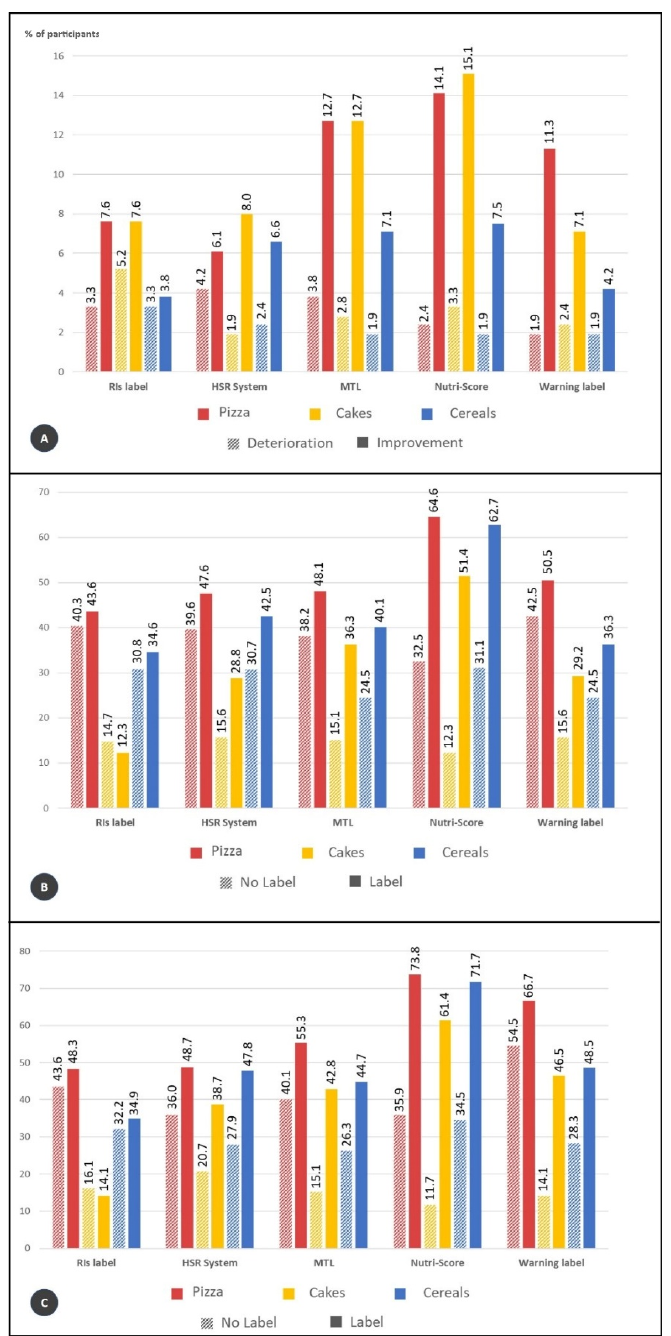
Figure 2. ( A ) Percentages of participants whose food choices deteriorated and improved; ( B ) Per- centages of participants providing correct answers for ranking tasks; ( C ) Percentages of participants providing correct answers for ranking task only among participants who recalled seeing the label during the survey.